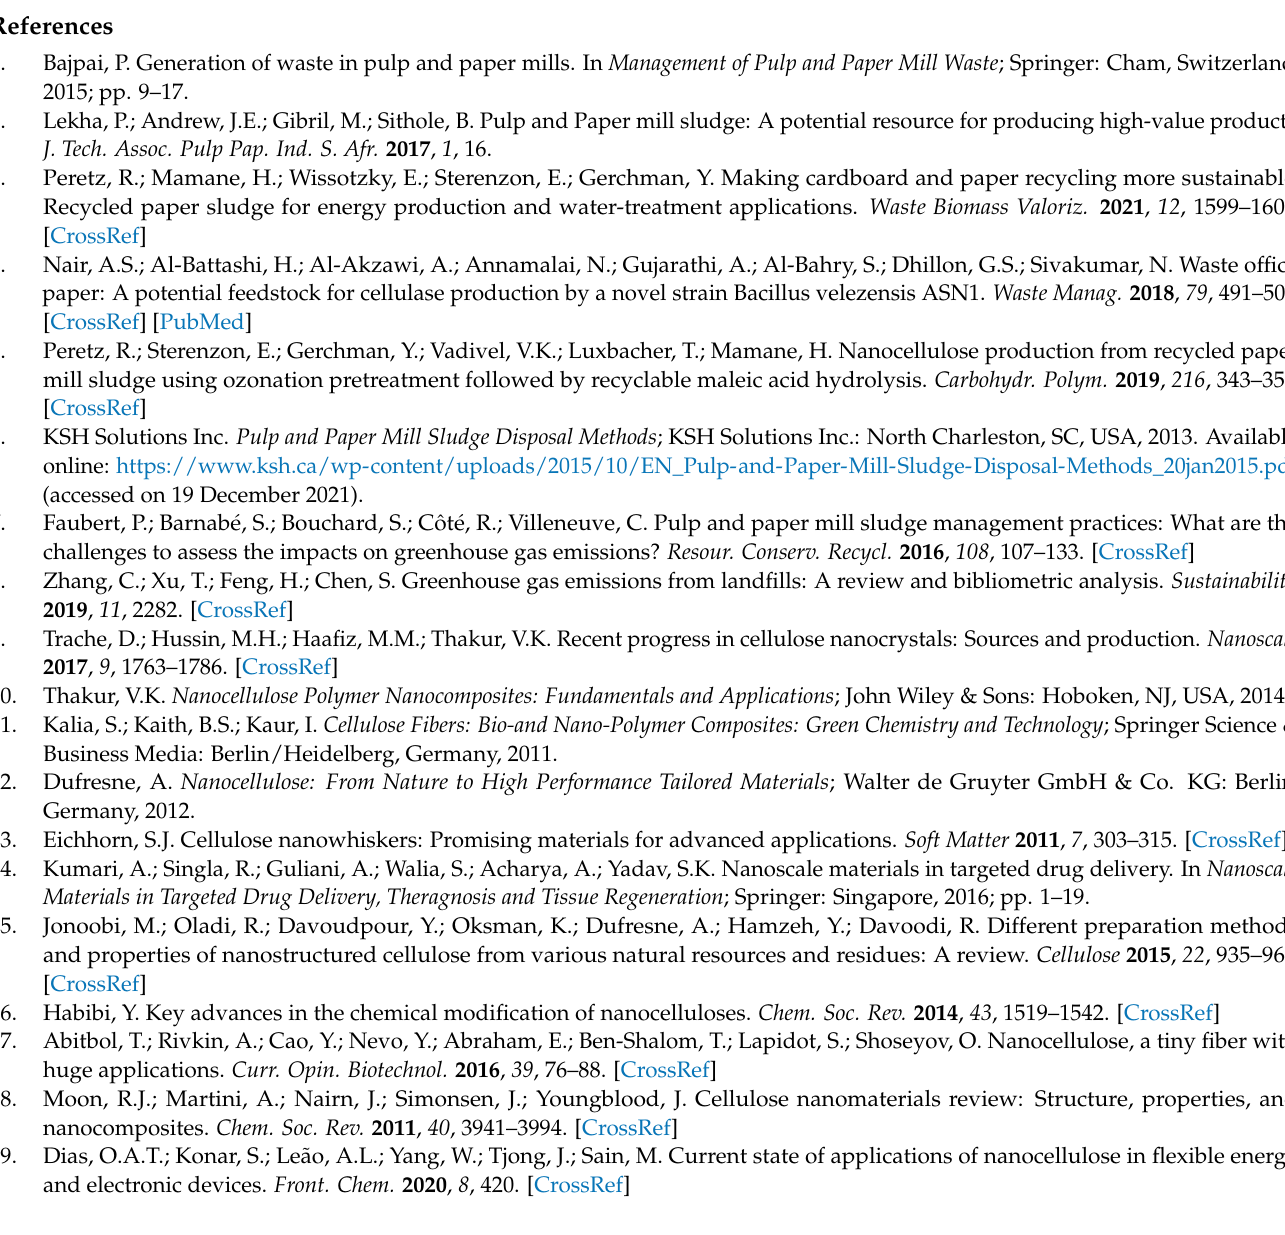
Figure A7. UV–vis spectra ( a ) and a calibration curve ( b ) of acid red 131